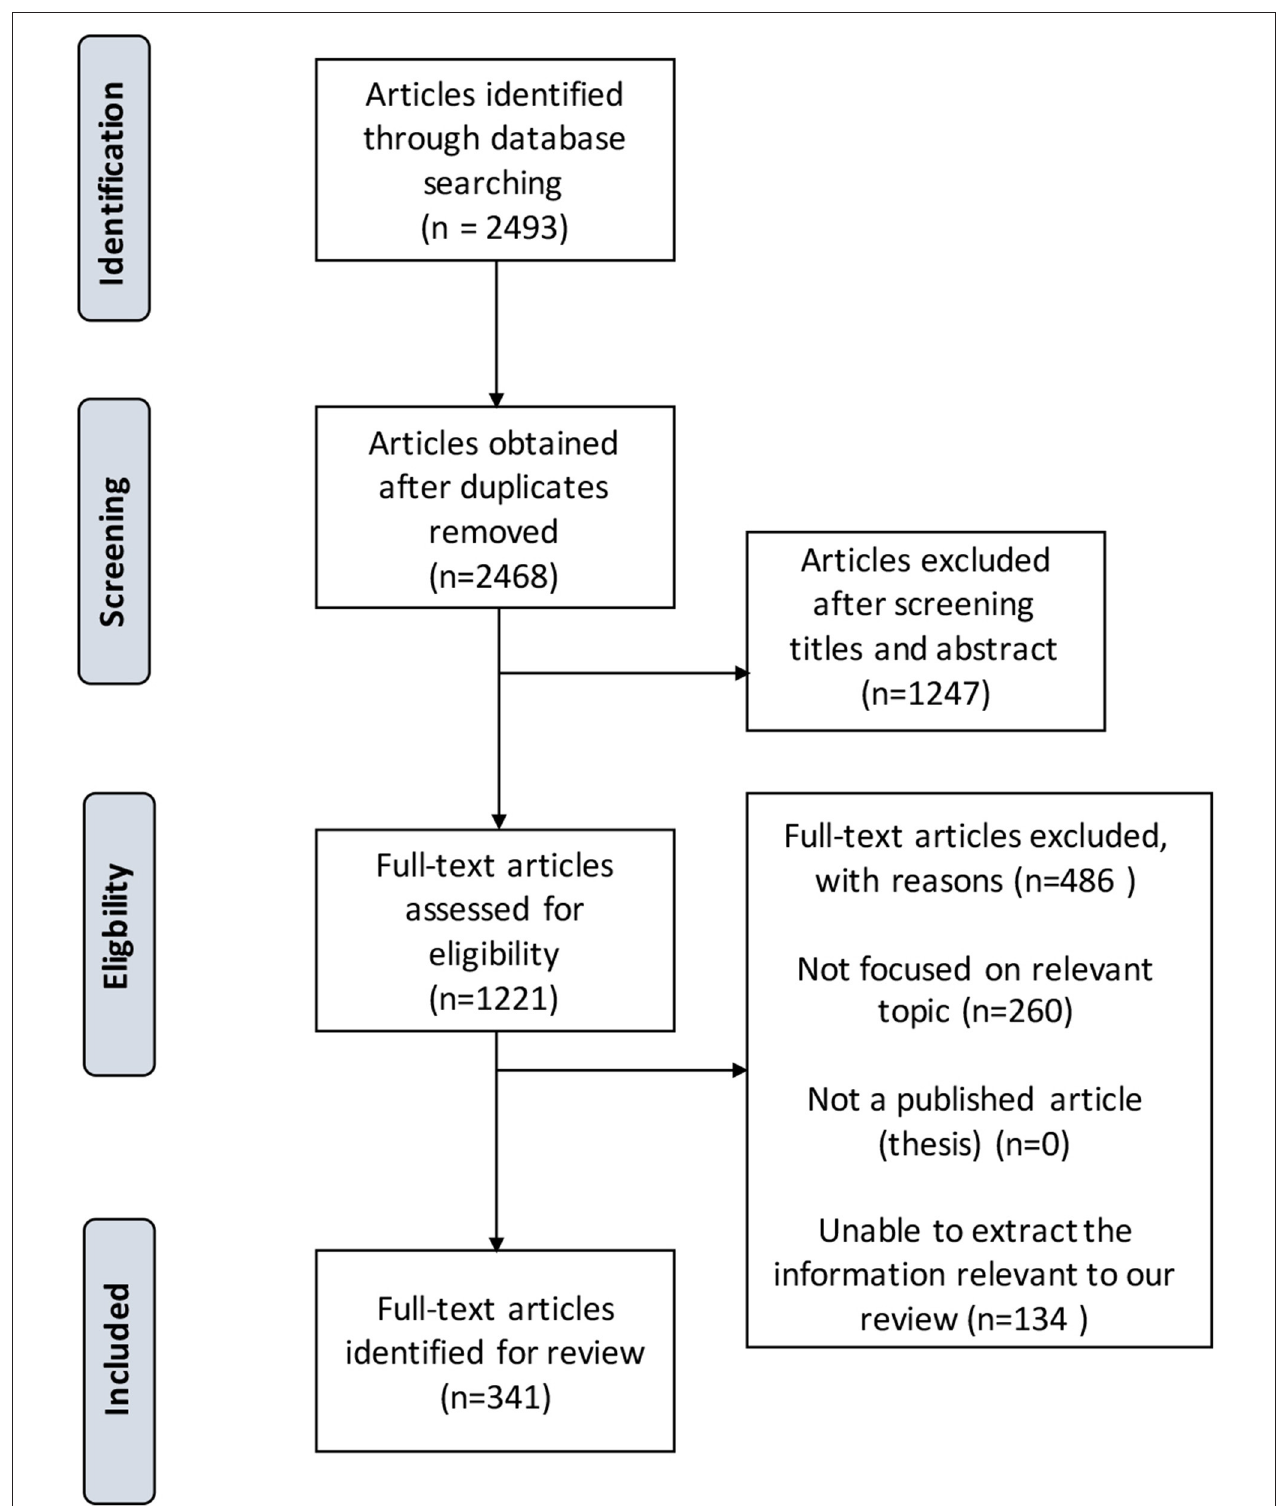
FIGURE 1 | PRISMA study flow diagram demonstrating the number of articles retained at each stage of data acquisition.